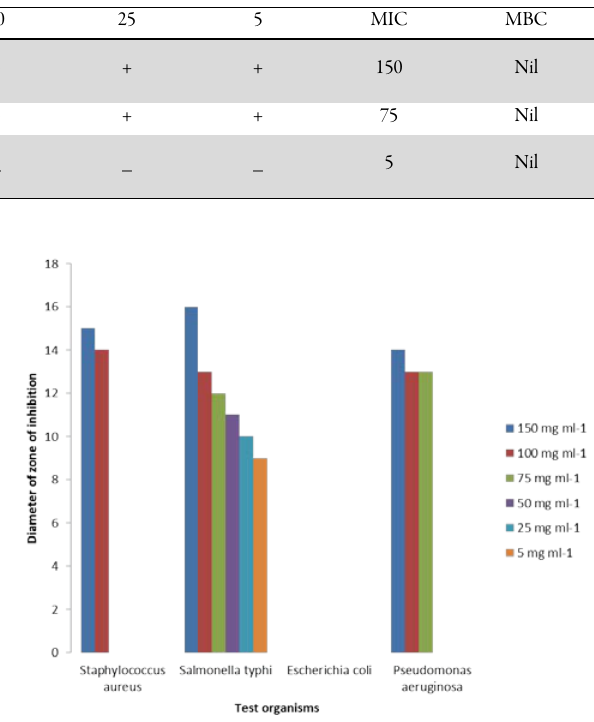
Table 3. Minimum inhibitory and bactericidal concentration of the methanolic extract Varying concentrations of the methanolic extract (in mg ml -1 )